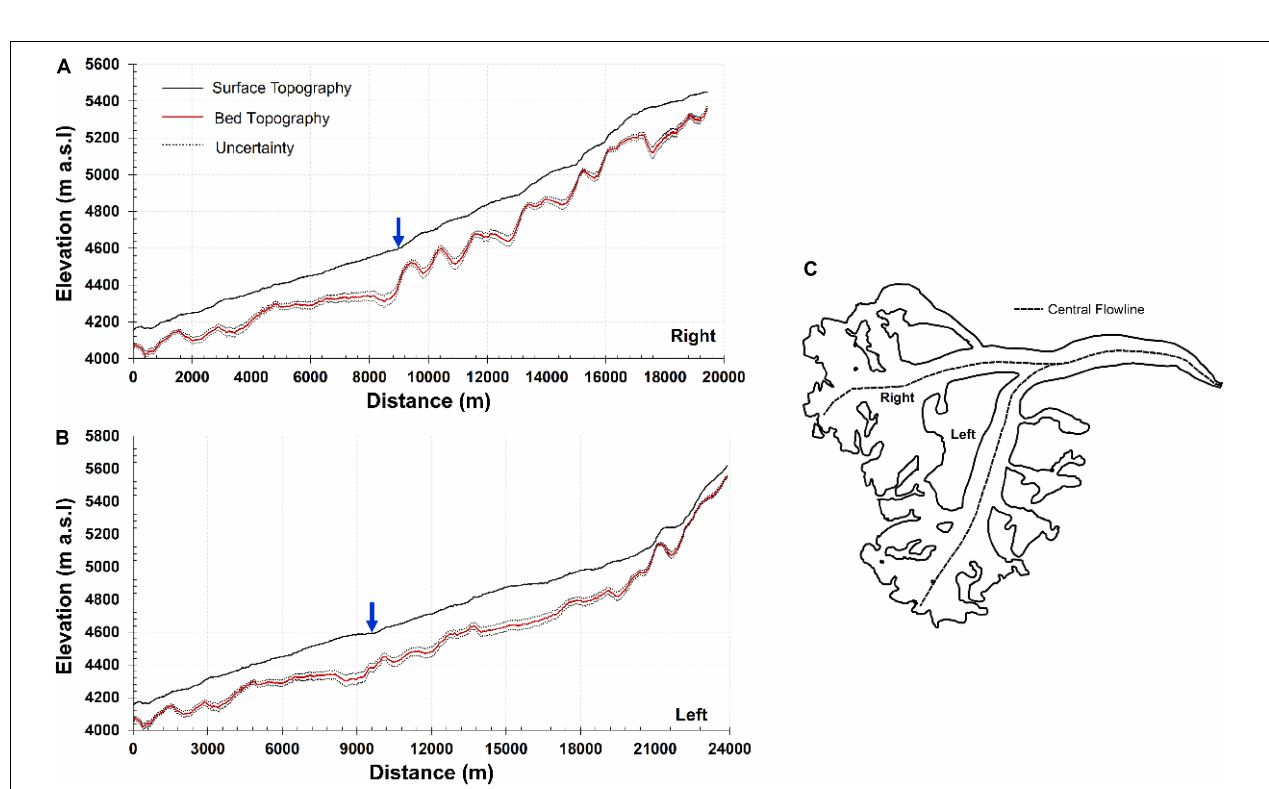
FIGURE 6 | Glacier surface and bed topographic profiles along the central flow line of (A) right and (B) left trunk of the Samudra Tapu Glacier. (C) Glacier boundary demarcated with left and right trunk of the glacier. The location of confluence (blue arrow) of the right and left trunks of the glacier is about 4600 m a.s.l.